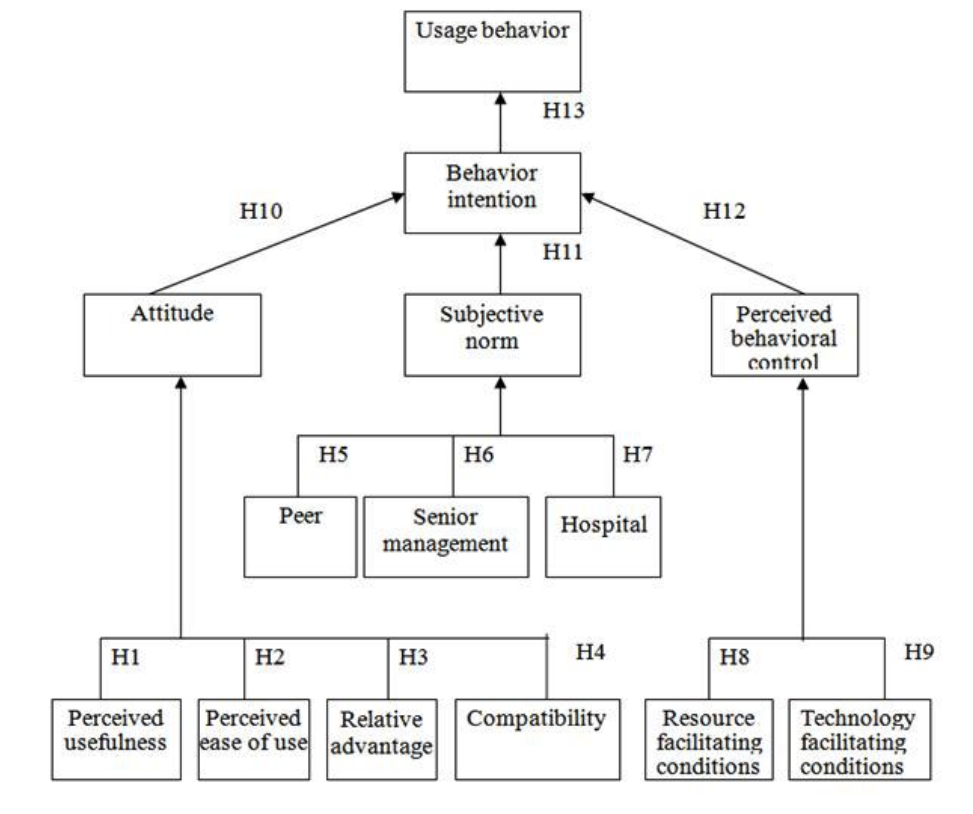
Figure 5. Proposed model for studying factors influencing the adoption of Web 2.0